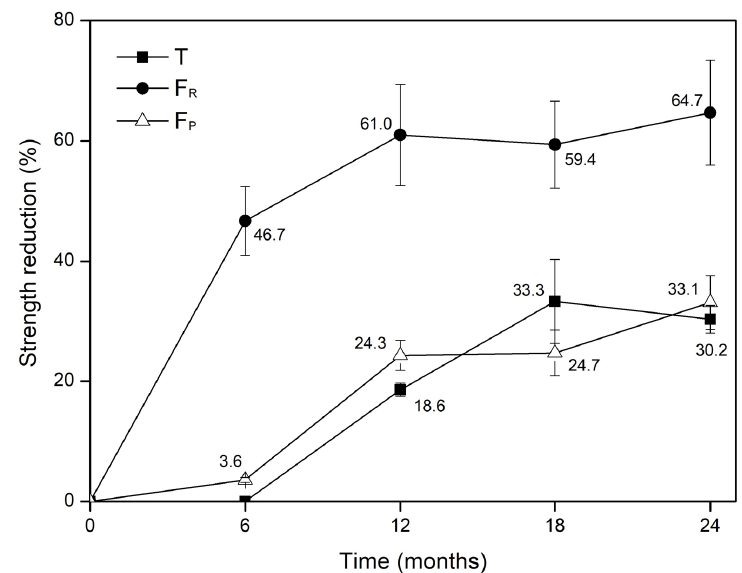
Figure 3. Reduction (in percentage) of mechanical strength over time. (Notation: T—tensile strength; F R —tearing strength; F P —puncture strength).